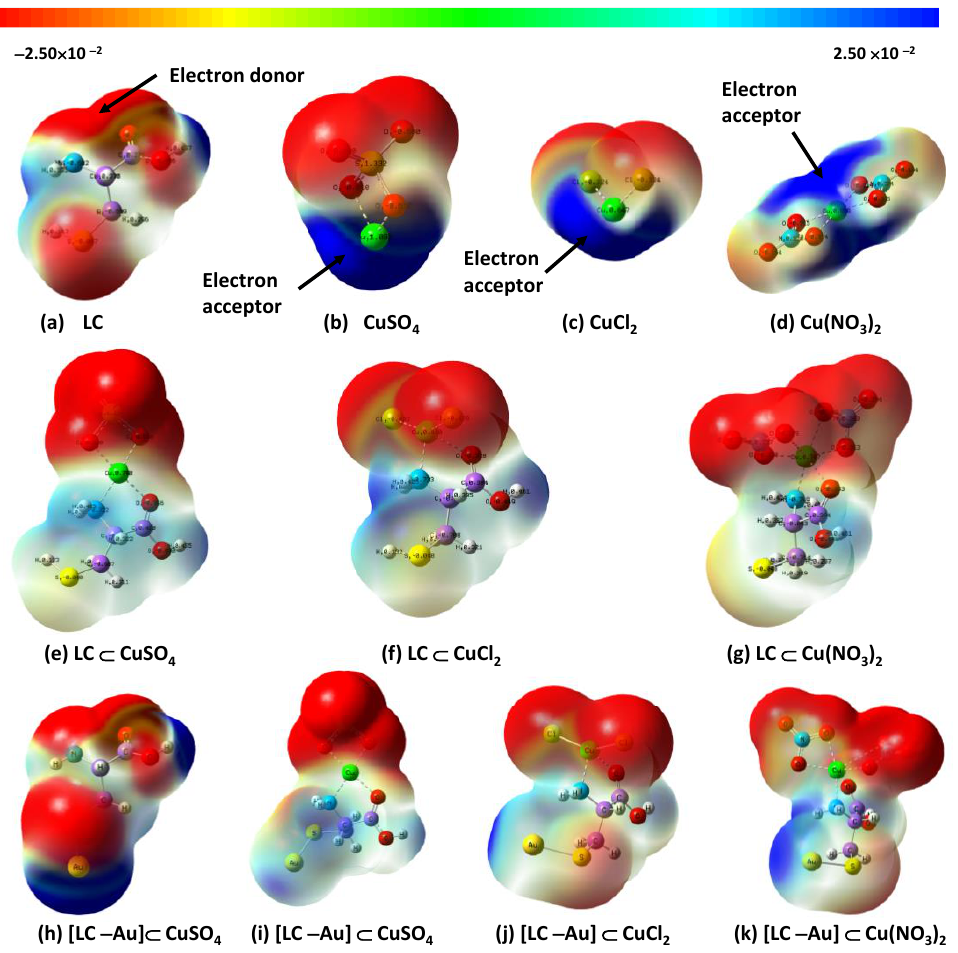
Figure 5. Optimized gas phase molecular structures, ESPs, lowest unoccupied molecular orbital (LUMO), and HOMO structures of ( a ) LC, ( b ) CuSO 4 ; ( c ) CuCl 2 ; ( d ) Cu(NO 3 ) 2 ; ( e ) LC ⊃ CuSO 4 ; ( f ) LC ⊃ CuCl 2 ; ( g ) LC ⊃ Cu(NO 3 ) 2 ; ( h ) [LC-Au]; ( i ) [LC-Au] ⊃ CuSO 4 ; ( j ) [LC-Au] ⊃ CuCl 2 ; and ( k ) [LC-Au] ⊃ Cu(NO 3 ) 2 at the ω B97XD/LANL2DZ level of theory in the water solvent system. Color code: carbon = purple, nitrogen = blue; oxygen = red; copper = green; chlorine = yellow-green; sulfur = yellow; gold (Au) = orange, and hydrogen atoms = white.